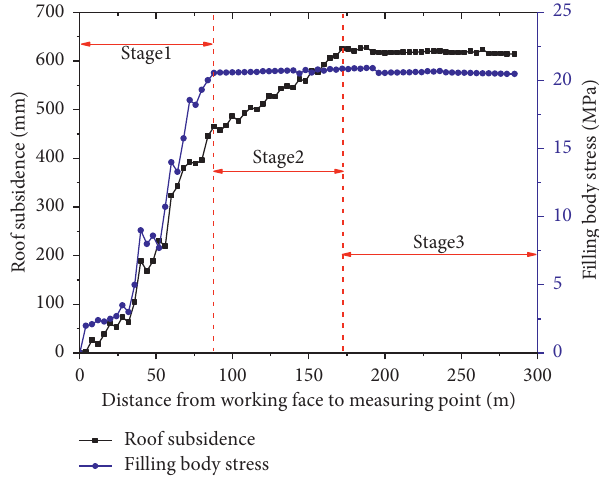
Figure 11: Roof dynamic subsidence